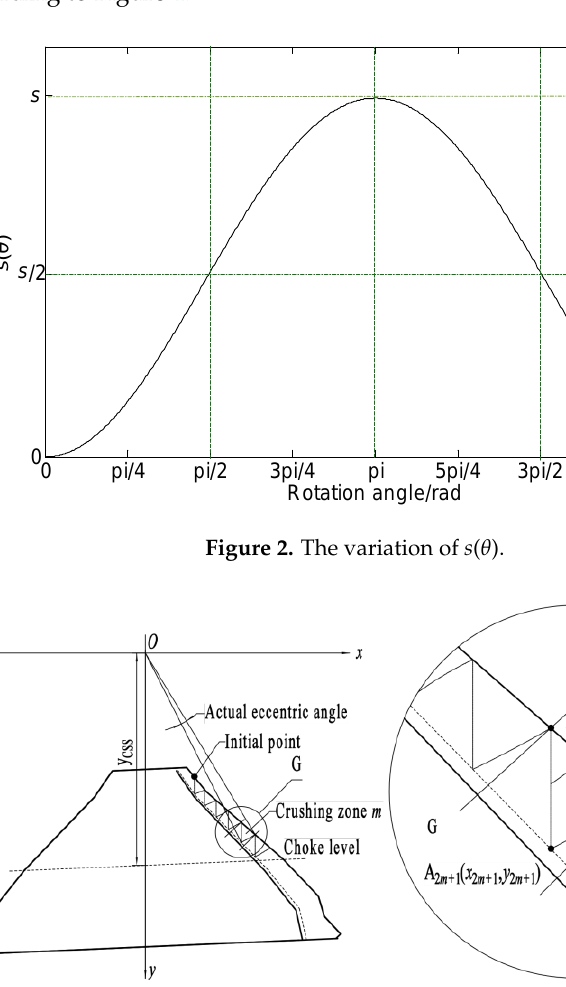
( b ) Figure 1. Cross section of crushing chamber: ( a ) surface pressure distribution of the mantle; ( b ) material movement trajectory.